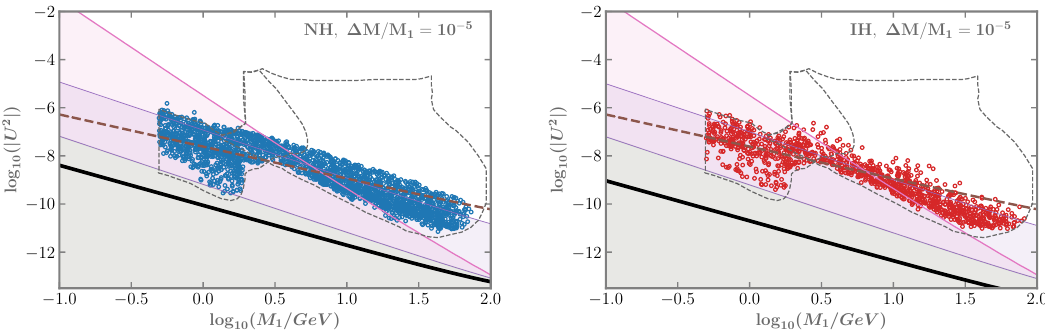
Figure 9 . Result of the numerical scan for ∆ M/M = 10 − 5 shown in blue (red) for NH (IH). The mixing is only bounded by the requirement of having a slow flavour α at T the shaded regions as in figure